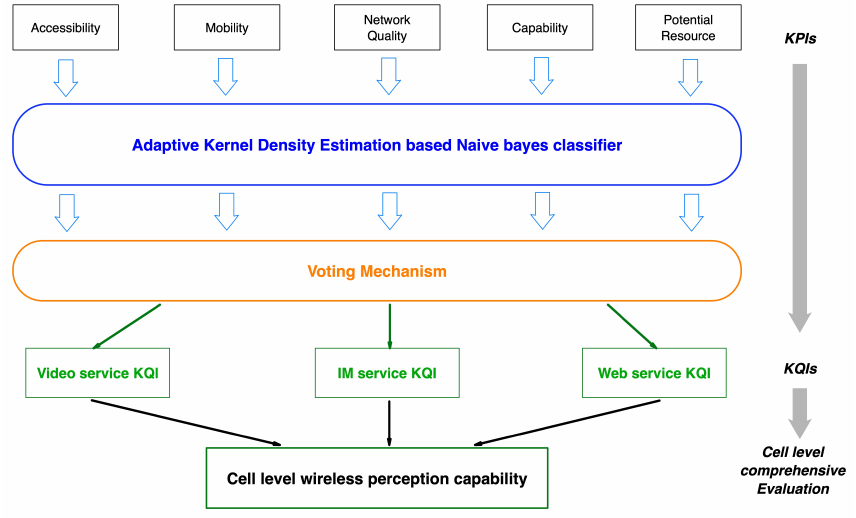
Figure 3. User experience